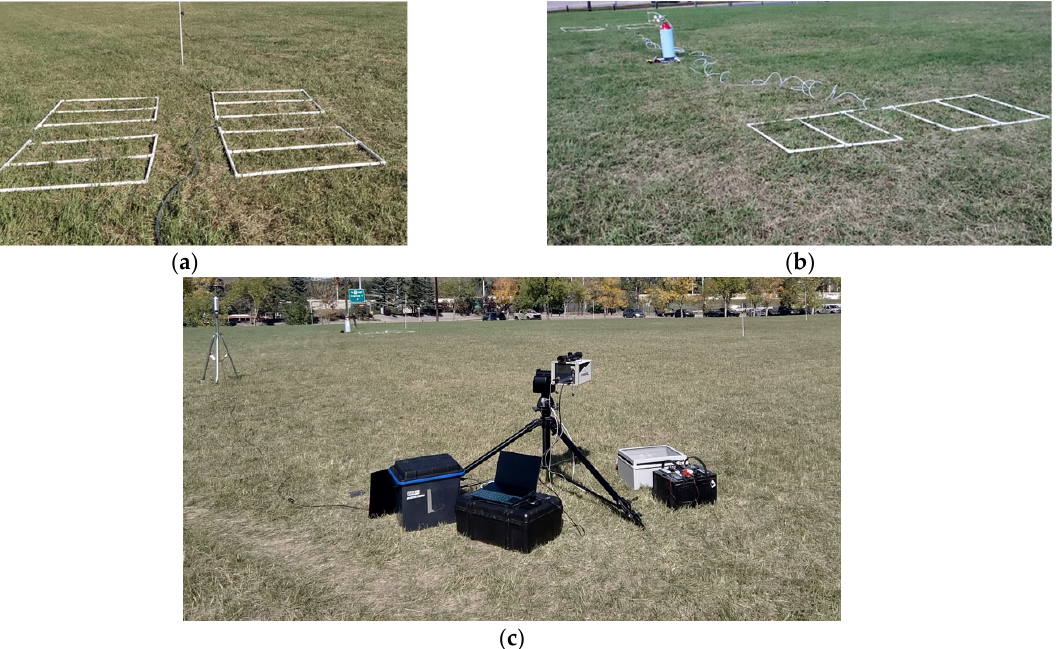
Figure 5. ( a ) Area source for Release One. ( b ) Area sources for Release Two. ( c ) The multi-path scanning TDL